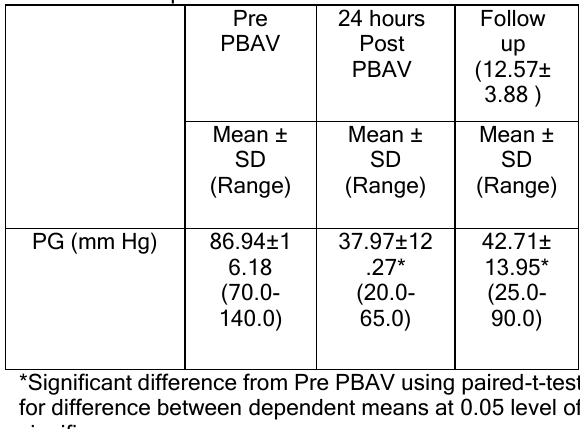
Table (5) : Aortic regurgitation pre PBAV , post PBAV and on follow up.